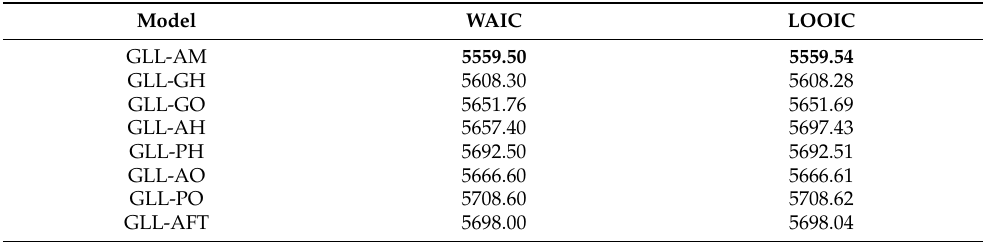
Table 9. Bayesian model selection between the proposed AM class and its sub-models using the GLL baseline